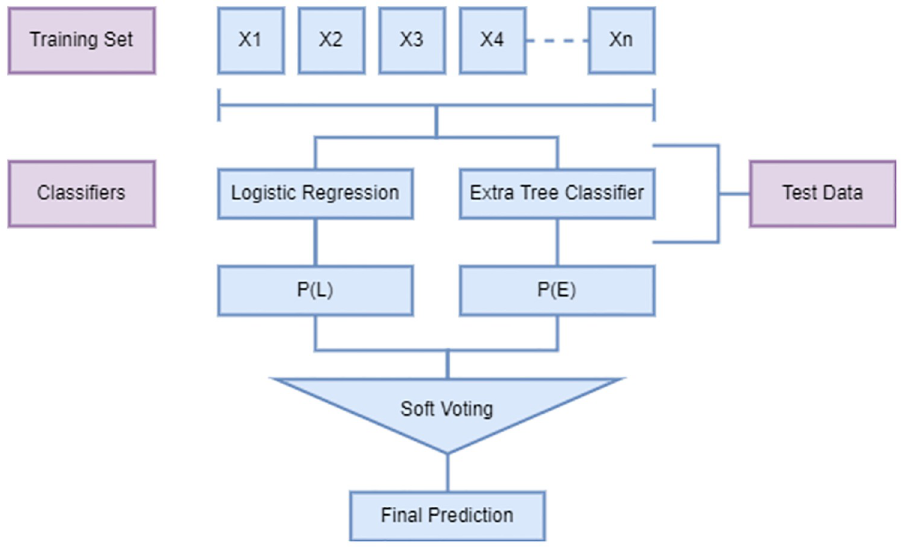
Fig 4. Framework of extreme regression-voting